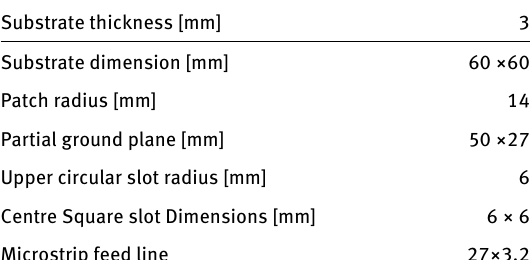
Table 3: Simulated Results of proposed